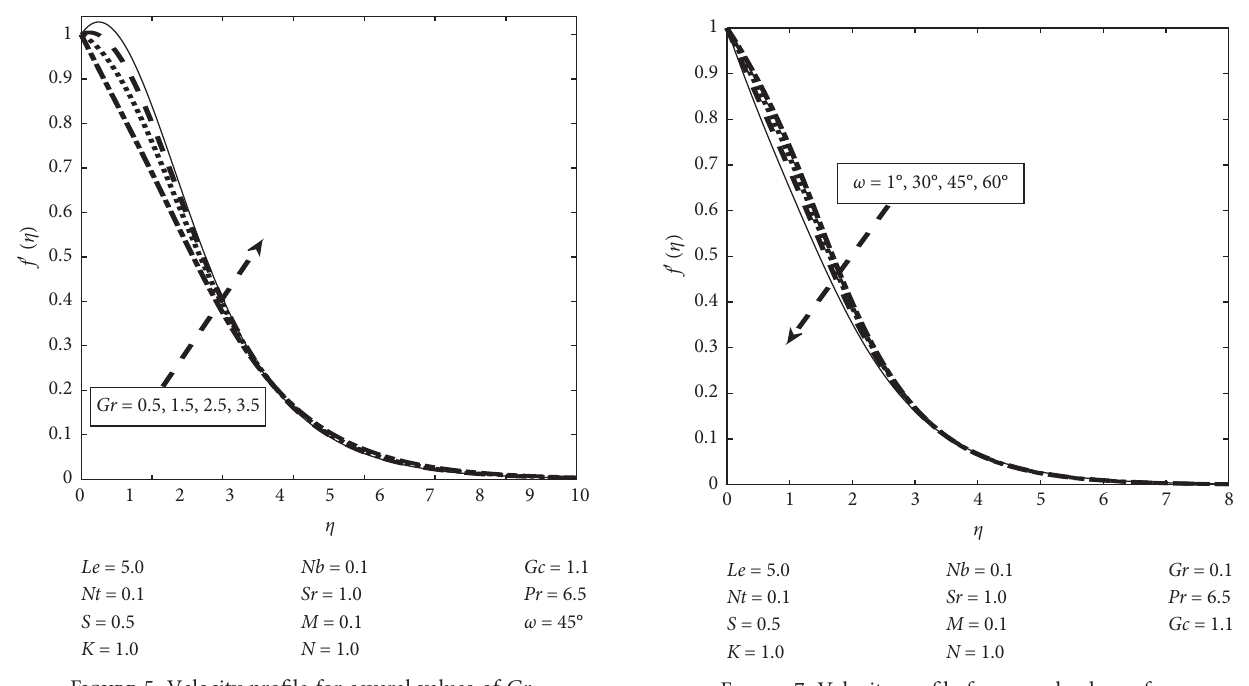
Figure 7: Velocity profile for several values of ω .